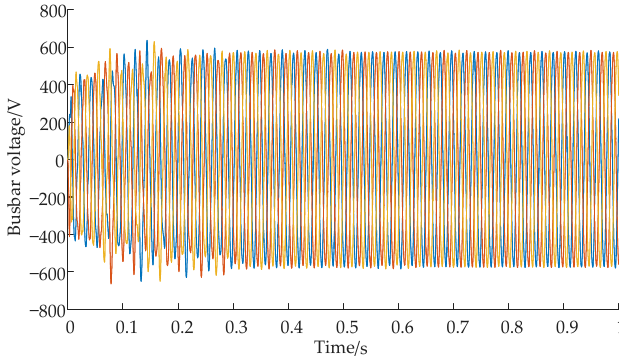
Figure 9. The bus voltage waveform when m 1 = 2.5 × 10 − 5 Hz/W and m 2 = 5 × 10 − 5 Hz/W. (2) When m 2 = 10 × 10 − 5 Hz/W, the root locus equation whose gain is m 1 is